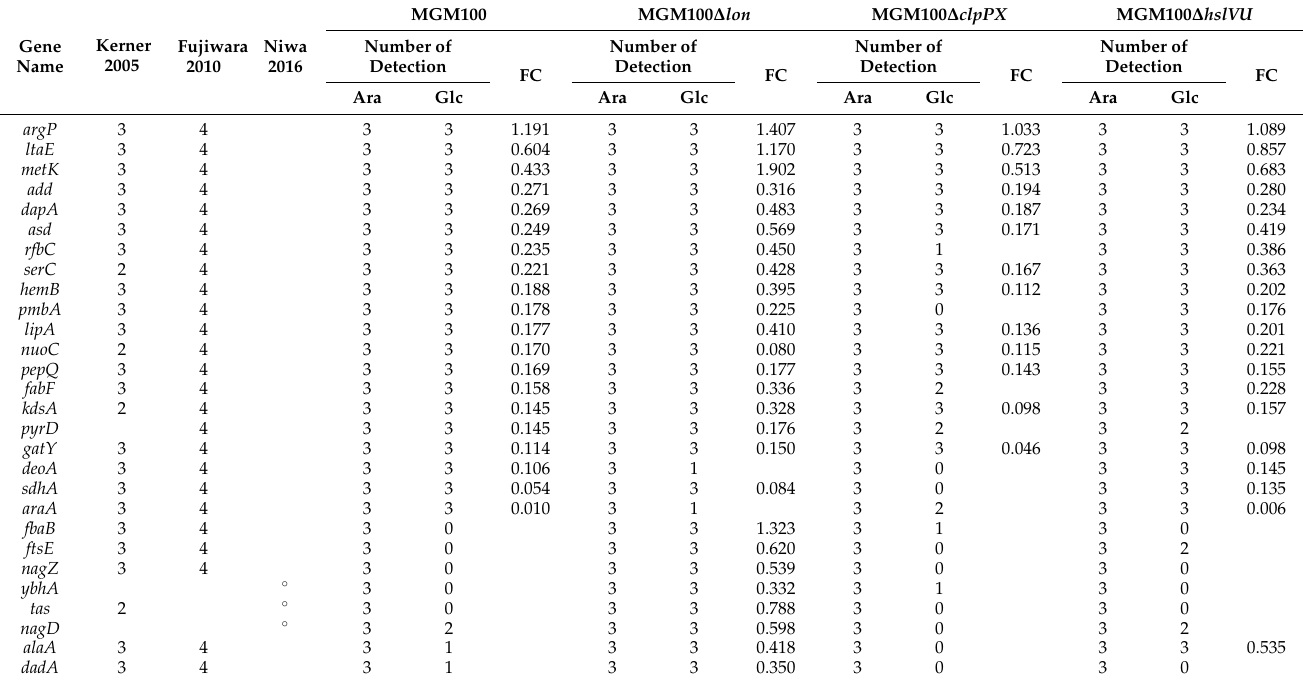
Table 1. Fold change values of the in vivo obligate GroE substrates in MGM100 and MGM100-derived protease-deletion